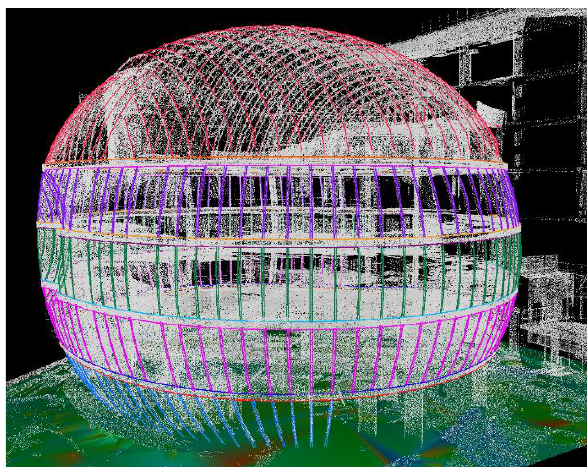
Figure 4 . 3D point cloud of the mall with shell's design.